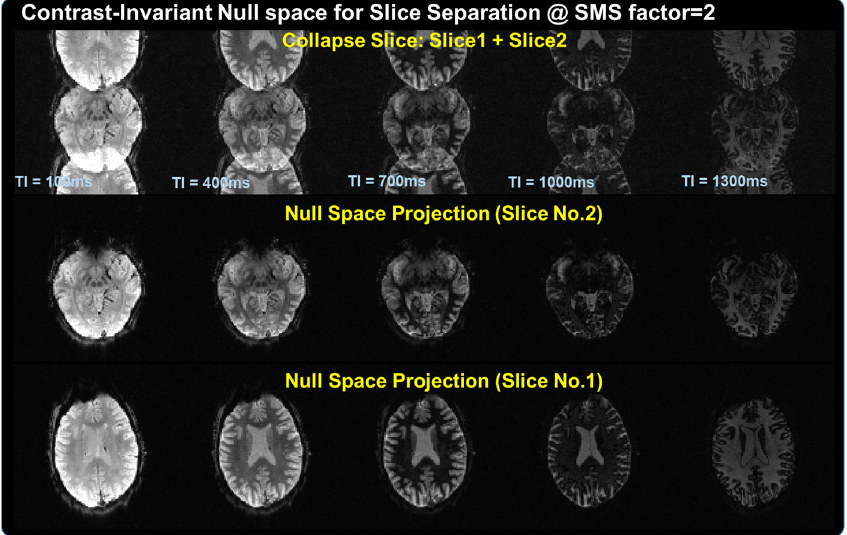
Figure 1. An illustration of the use of null space for slice separation. This work hypothesizes that the null space is invariant along the parameter dimension. The null space projection effectively filters out a slice of no interest while passing through a slice of interest regardless of contrast